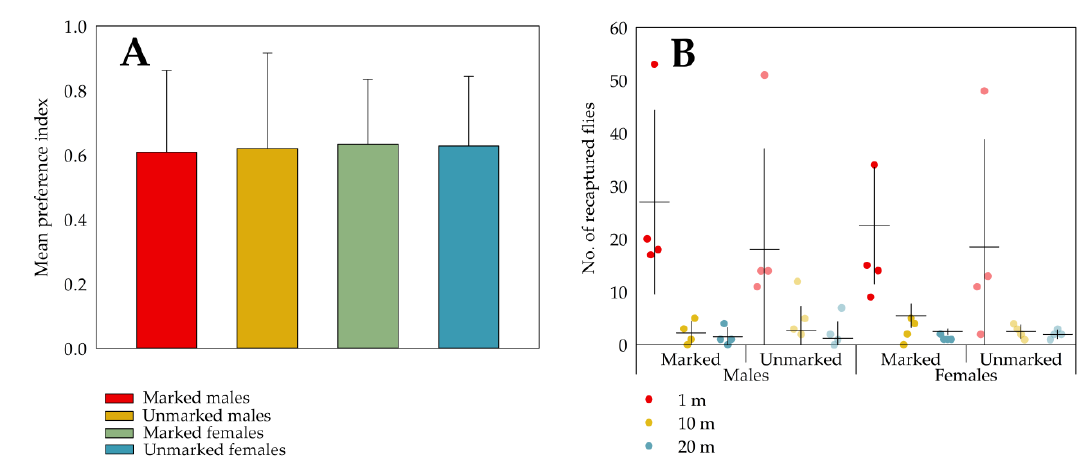
Figure 5. The e ff ects of marking with fluorescent pigments (Radglo ® TP-series) using the “Shaking” technique on the behaviour of D. suzukii was evaluated both in the laboratory and field. In the laboratory evaluation, for each trap assay unit (n = 12), the preference index (PI) was calculated and means ± SD for each marking-sex combination are shown ( A ). No statistically significant e ff ects of marking, sex or their interaction on the PI could be denoted. For the field evaluation, the numbers of recaptured flies throughout the experiment for each grid are depicted as dots, the means (n = 4) are shown as horizontal lines and the vertical lines indicate the SDs ( B ). For both sexes no statistically significant di ff erences could be denoted between the mean number of marked and unmarked recaptured flies for each distance from the release point.